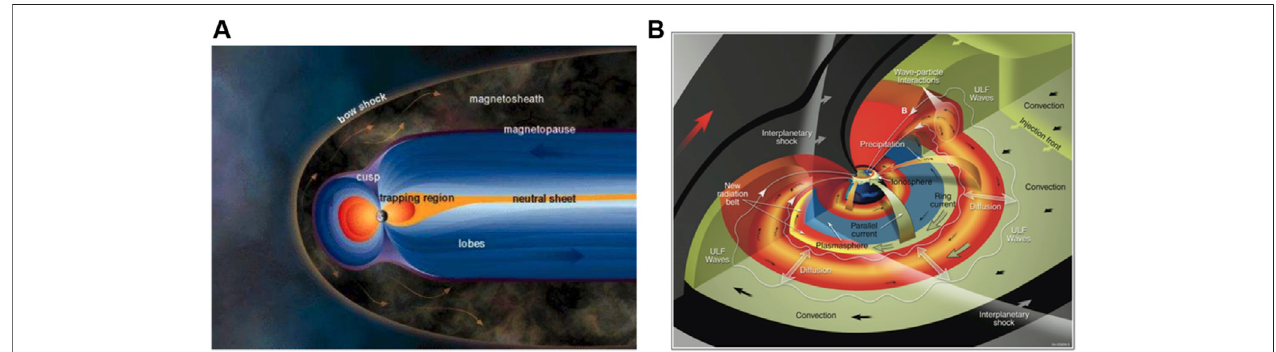
FIGURE 10 | (A) The Earth ’ s outer magnetosphere with the bow shock, magnetosheath, magnetopause, tail lobes, and tail current sheet (also called the neutral sheet) shown. The Sun is assumed to be on the left of the image, thus the solar wind compresses the dayside (or sunward) magnetosphere, while it stretches